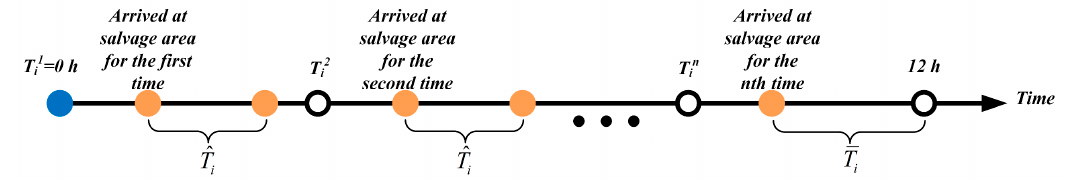
Figure 3. Time of the salvage vessel participating in green tide emergency disposal operations.